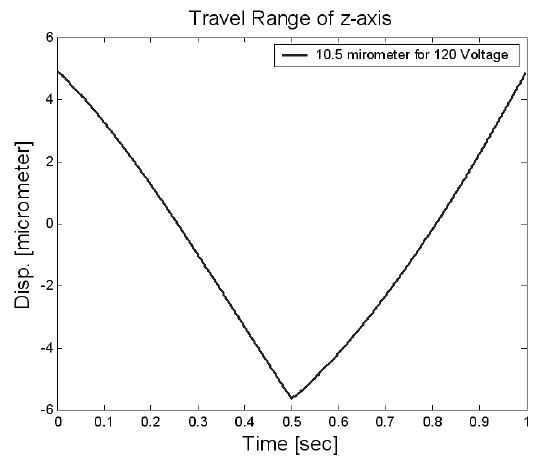
Figure 8. Travel range of the z -scanner.